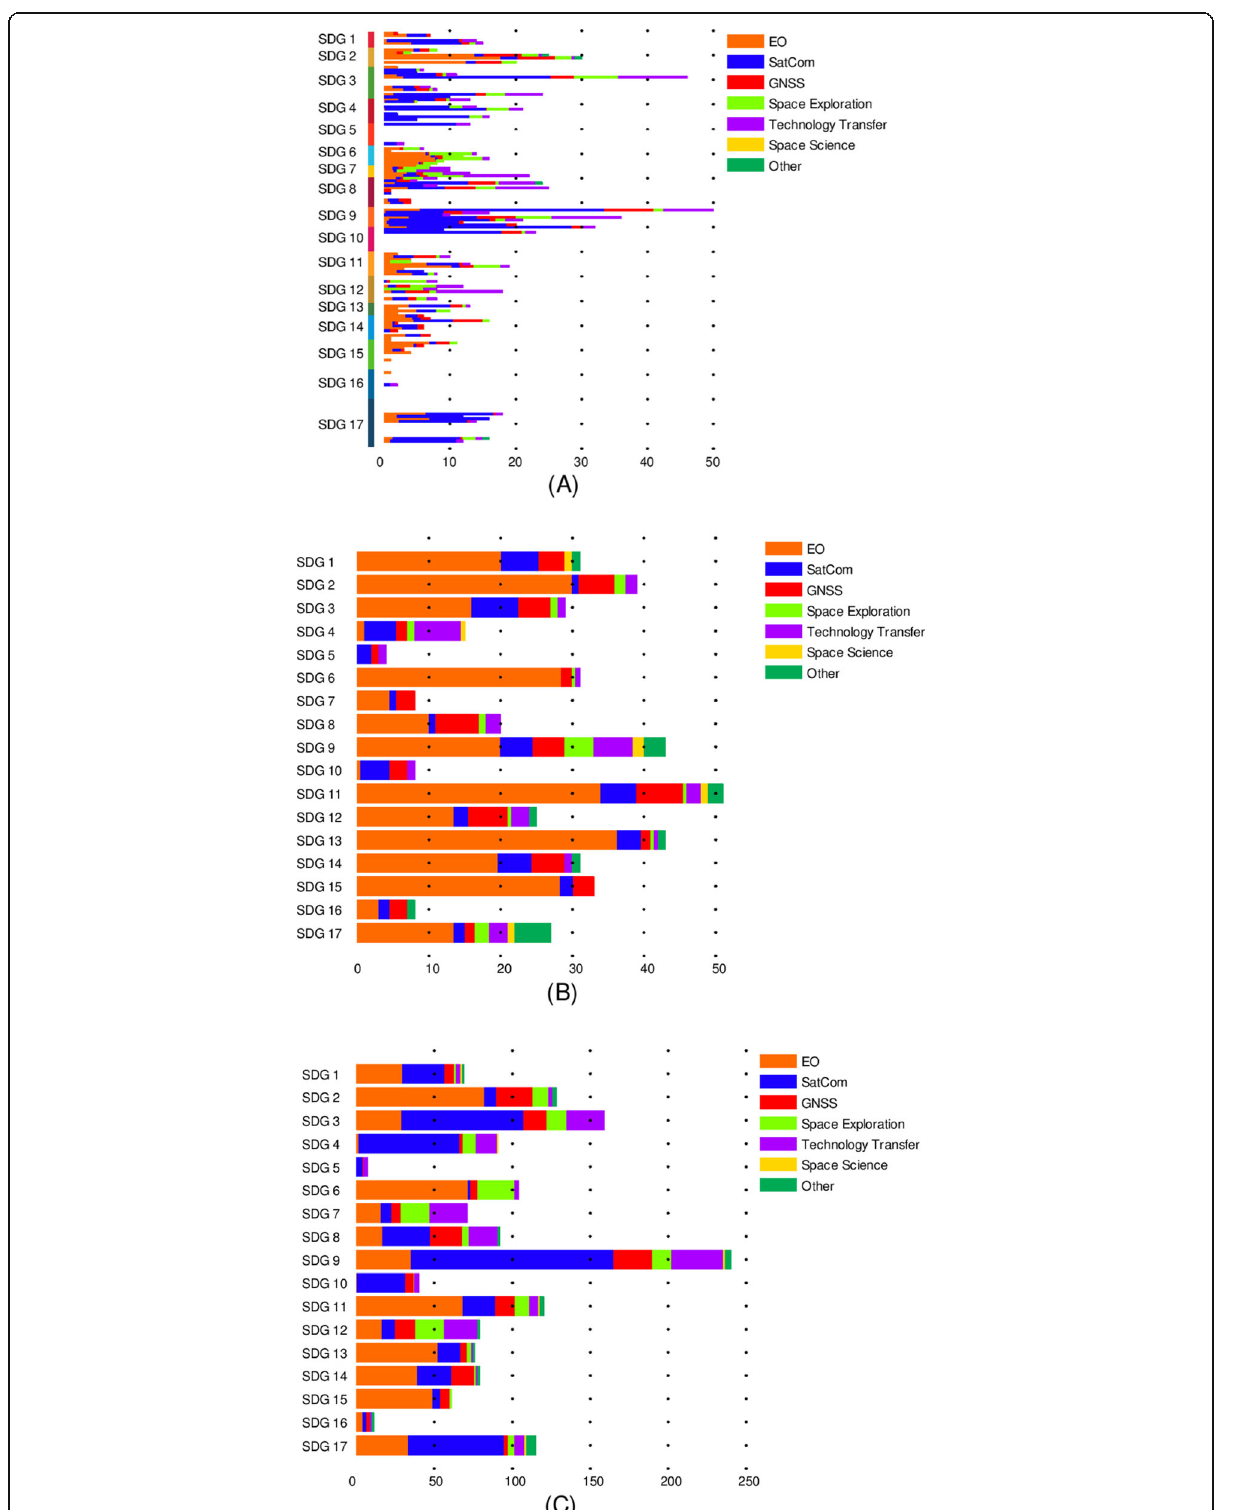
Fig. 6 Share of the various technologies for each SDG at Target level (6.A), Goal level (6.B) and aggregated view of Target and Goal level